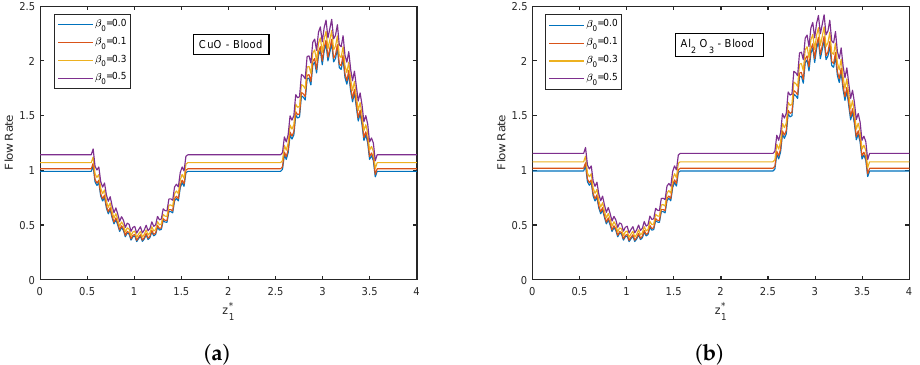
Figure 20. Flow rate profiles of viscosity parameter β 0 for ( a ) CuO-nanoparticles, ( b ) Al 2 O 3 - nanoparticles at t ∗ = 1